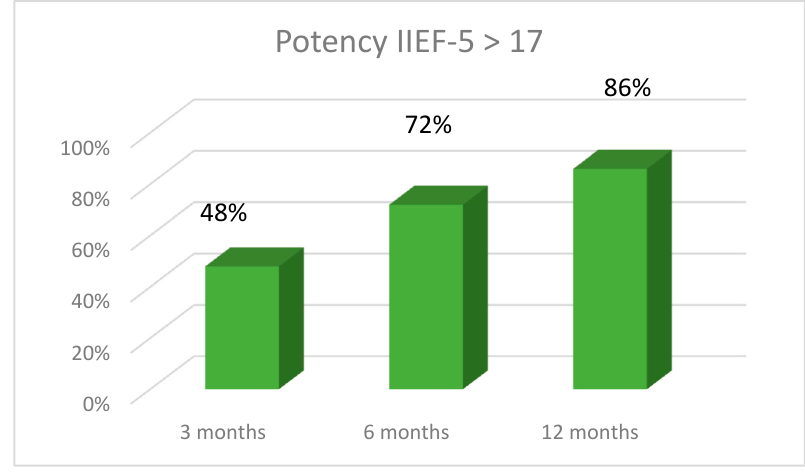
Figure 2. Potency rate after Perusia RARP.